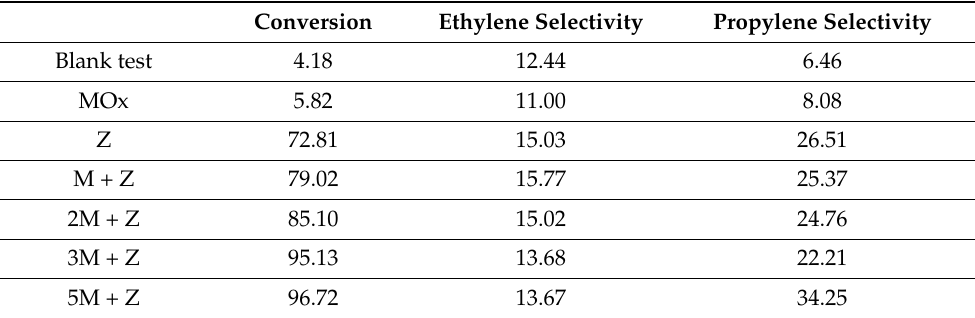
Table 3. n -Octane conversion and selectivities of ethylene and propylene in the sequential reactions and reference reactions.